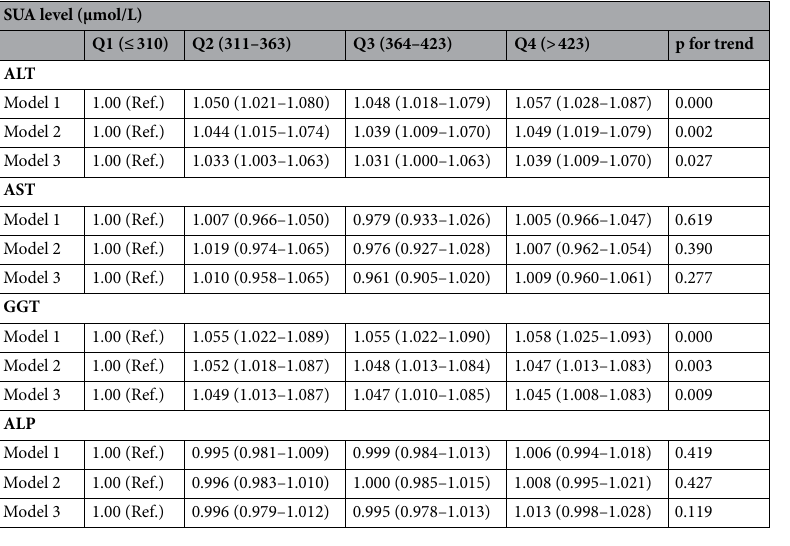
Table 5. Association between SUA and liver enzyme across the quartiles. Multinomial logistic regression analysis was done to assess the relationship between SUA and liver enzymes. Dependent variable is SUA (µmol/L) and the independent variable is liver enzymes (U/L). Reference category is SUA quartile Q1. Model 1: adjusted for age (years) and sex (male and female). Model 2: model 1 + BMI and FBG. Model 3: model 2 + SBP, DBP and lipid profile markers. OR odds ratio, CI confidence